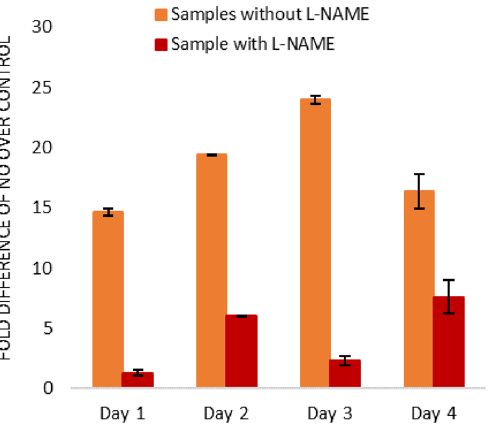
Figure 5. Increased NO production at various times after exposure of primary human keratinocytes to